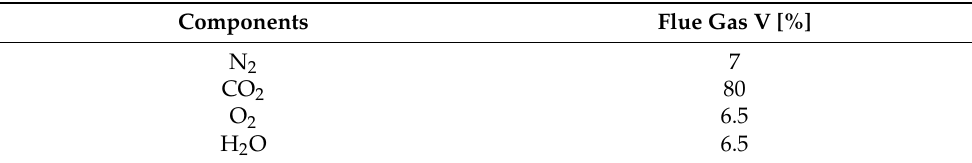
Table 4. Flue gas